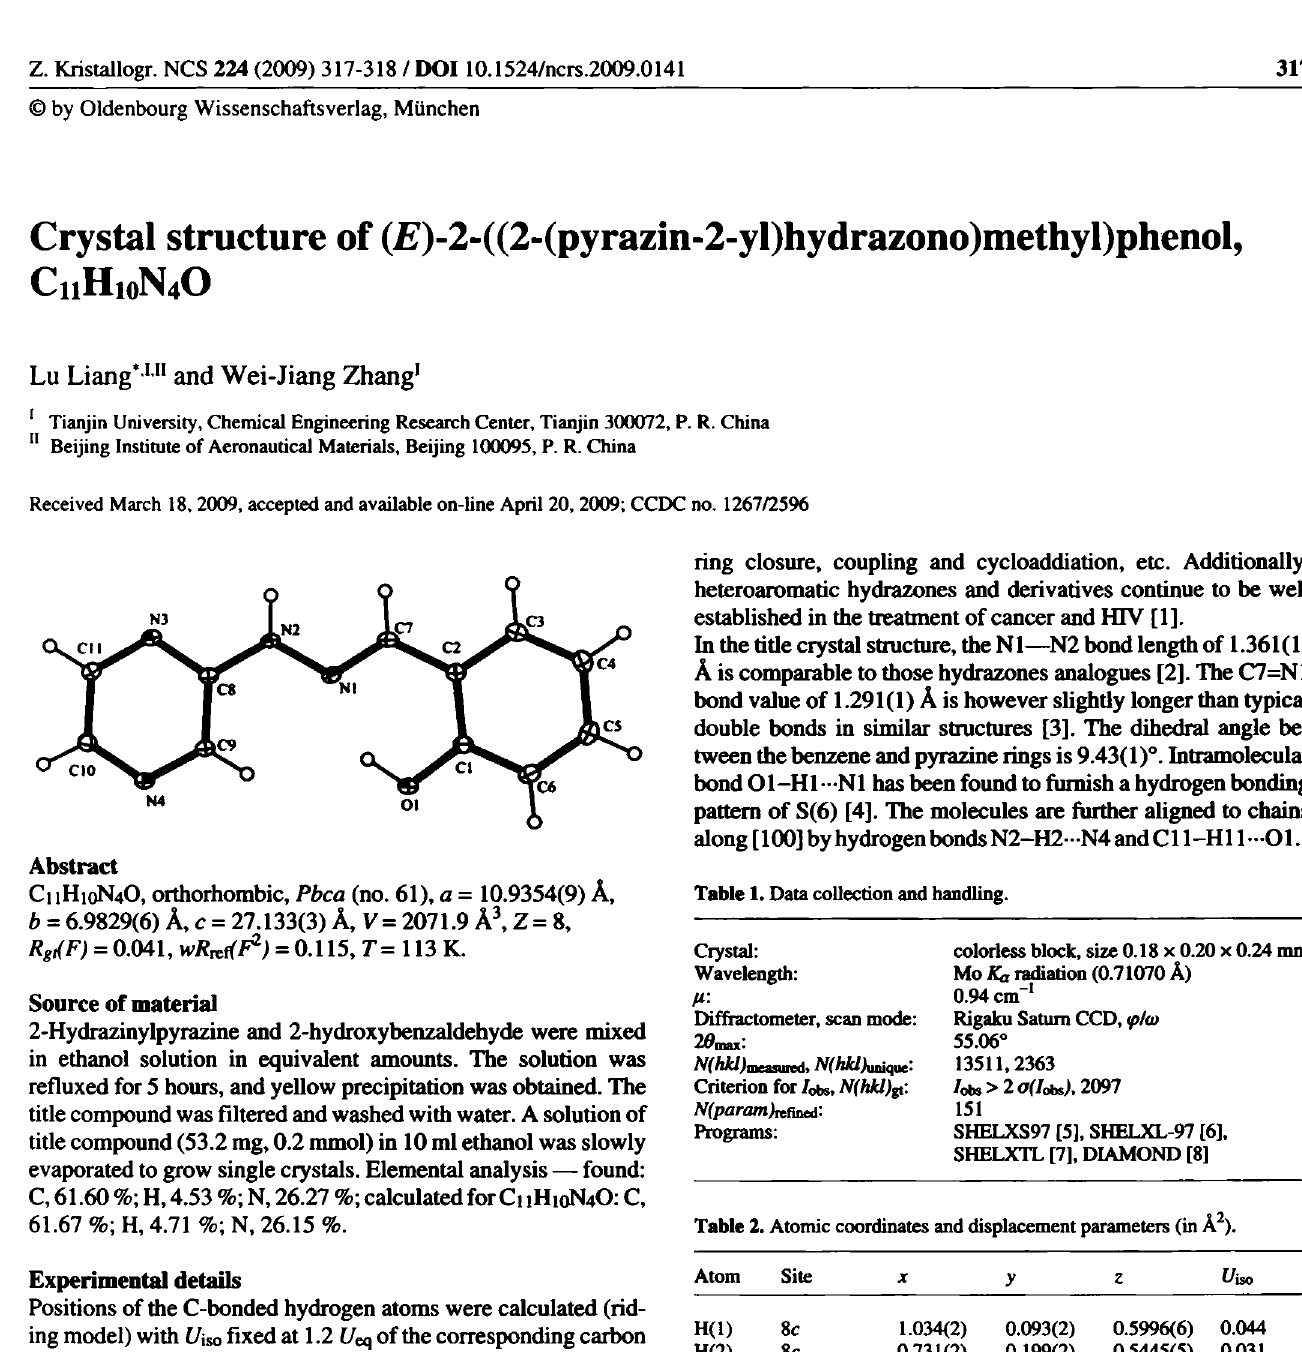
Table 2. Atomic coordinates and displacement parameters (in Â 2 ).